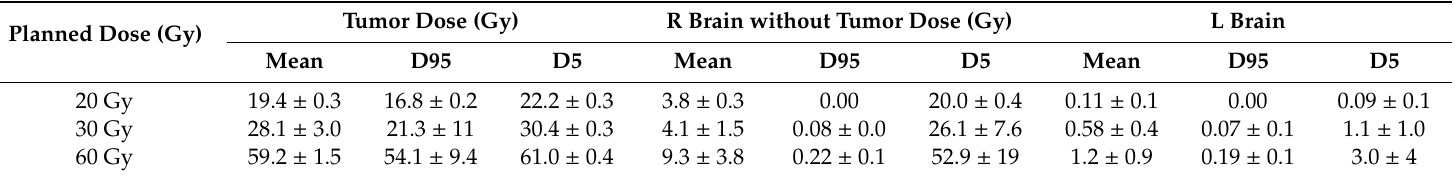
Table 1. Dose–volume histogram metrics for di ff erent tissue structures (tumor, right brain (R brain) without tumor, and left brain (L brain)) in treated animals (20, 30 or 60 Gy as indicated) using the AP-PA radiation treatment plan (Plan 4). Numbers are the mean and standard deviation of n ≥ 7 animals per treatment group. D95 = dose to 95% of the target volume; D5 = dose to 5% of the target